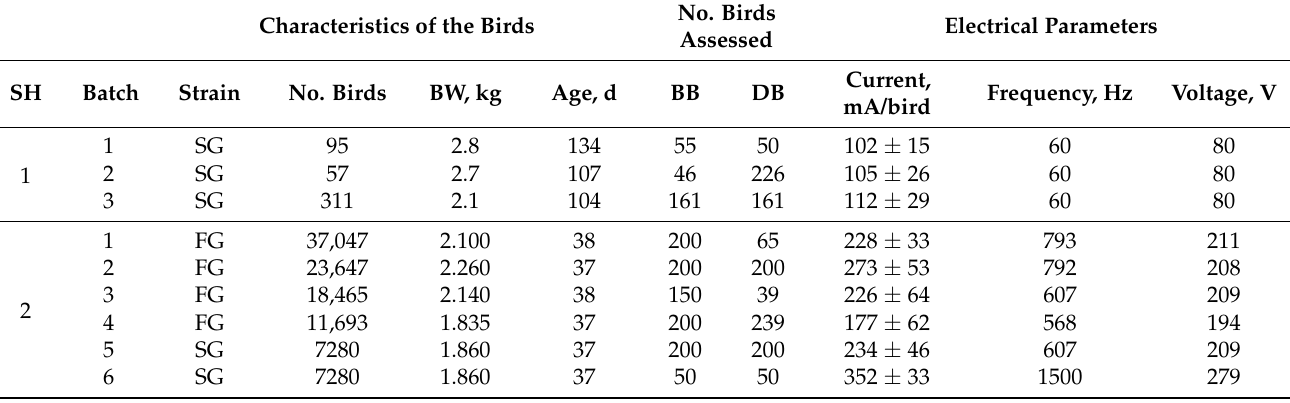
Table 2. Number of batches of slaughtered broilers, type of strain, average body weight and age of broilers per batch for each slaughterhouse. The number of broilers assessed before and during bleeding and the average electrical parameters ± standard deviation of the waterbath are reported. Characteristics of the